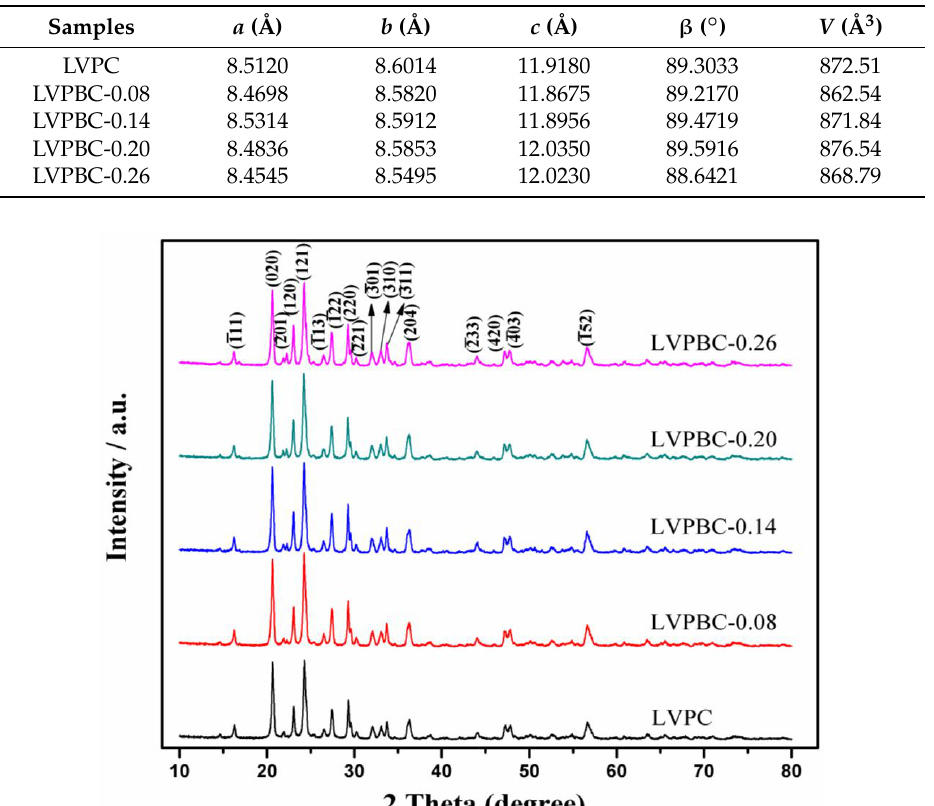
Figure 1. X-ray diffraction (XRD) patterns of the LVPBC and pristine LVPC composites.